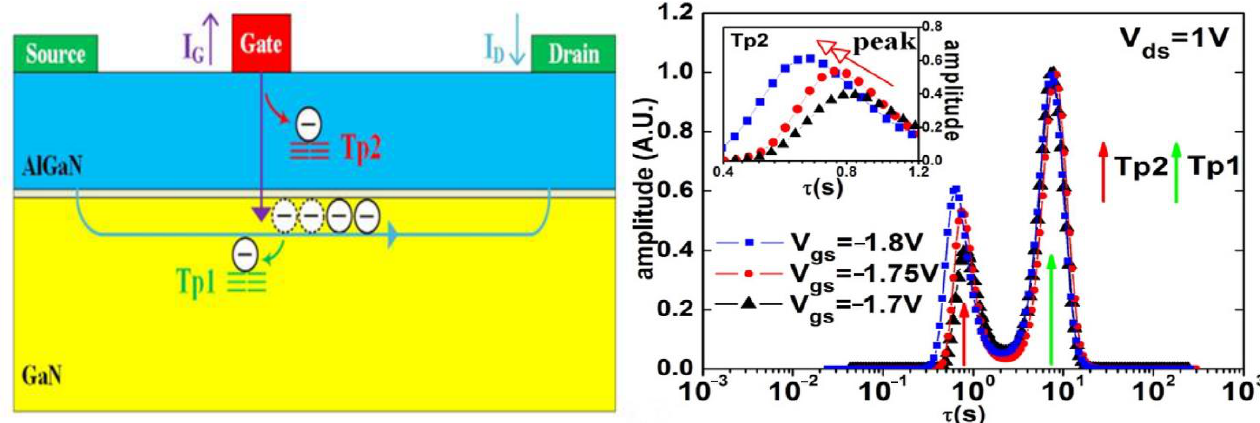
Figure 35. Trapping process of TP1 and TP2 with various values of V GS . Reproduced with permis- sion [162]. Copyright 2016, Elsevier.